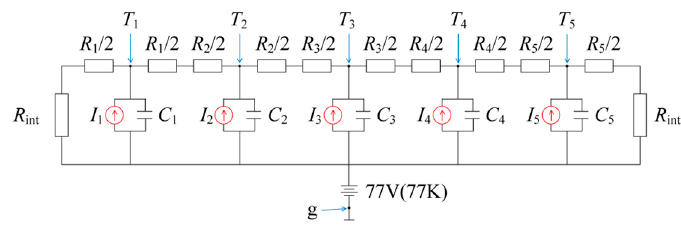
Figure 6. Thermoelectric equivalent model of coated superconductors.